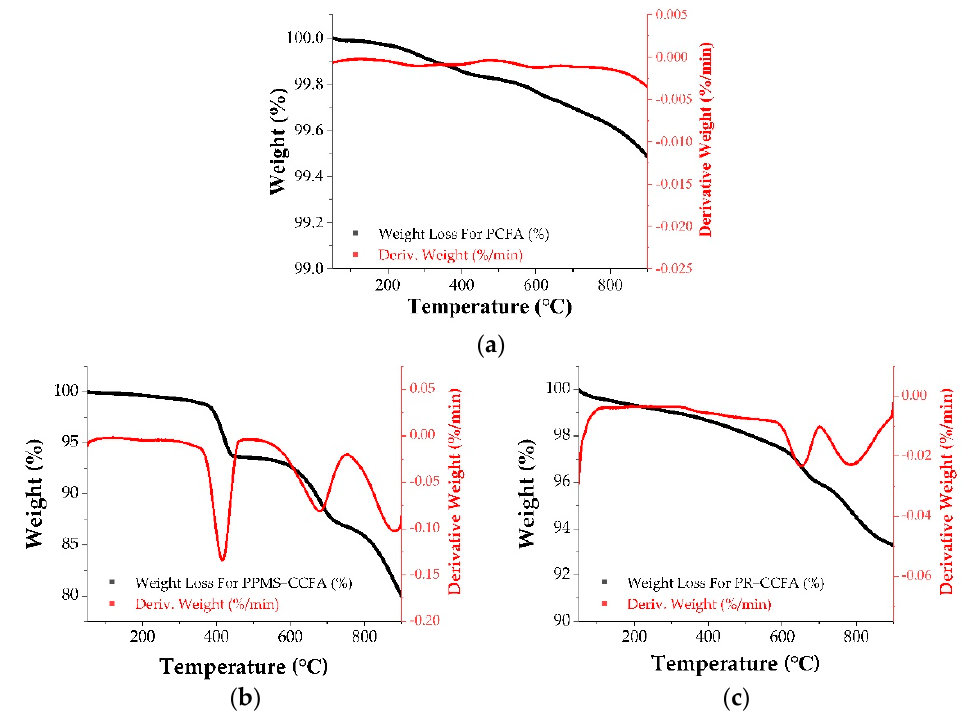
Figure 3. TGA and DTG heating curves of ( a ) PCFA, ( b ) PPMS-CCFA, ( c ) PR-CCFA.